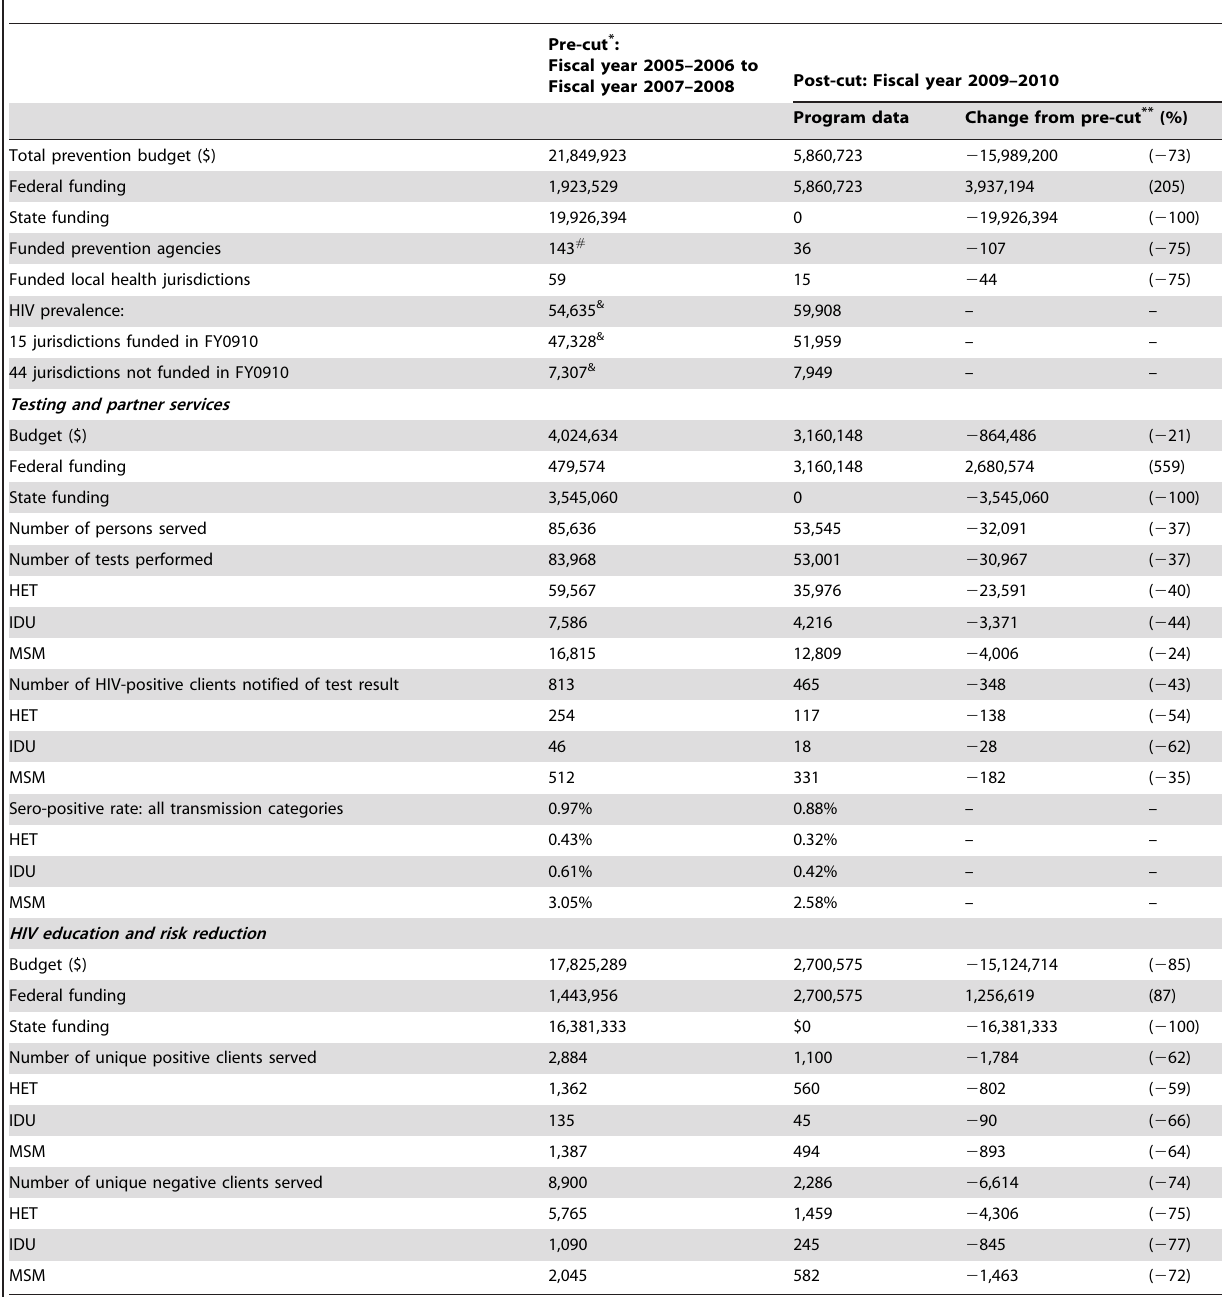
Table 2. Summary of HIV prevention budget, services and providers funded to selected jurisdictions by the California Office of AIDS (excluding Los Angeles and San